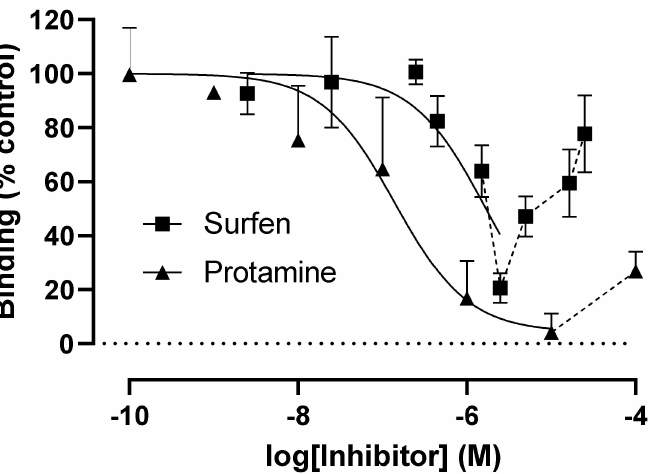
Figure 8. Glycosaminoglycan-binding molecules surfen and protamine sulphate can inhibit wtS1S2 binding. RT4 cells were preincubated with the stated concentrations of surfen or protamine sulphate for 30 min at 37 ◦ C, then with 100 nM wtS1S2 for a further 60 min at 37 ◦ C. Bound wtS1S2 was detected using fluorescent secondary anti-His6, measured by flow cytometry. Data are shown as a percentage of the wtS1S2 attachment to untreated control cells. Data are the means ± SEM of 3–4 experiments performed in